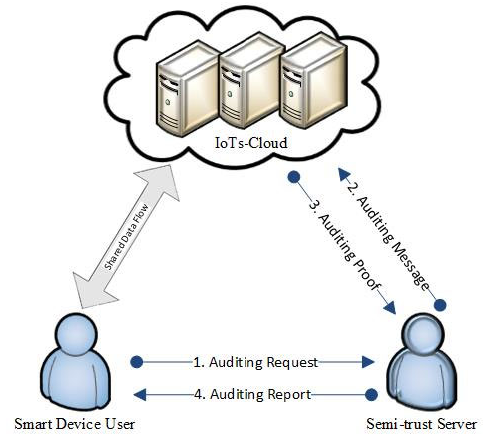
Figure 1. Architecture of the traditional scheme.